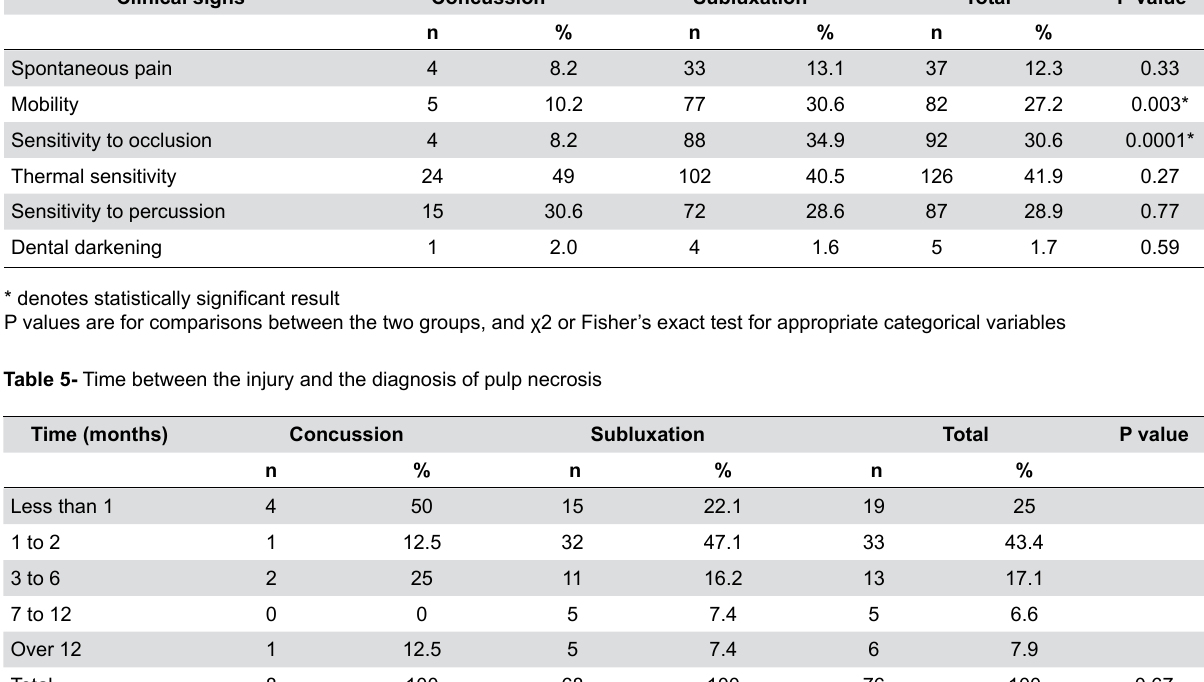
* denotes statistically significant result P values are for comparisons between the two groups, and χ2 or Fisher’s exact test for appropriate categorical